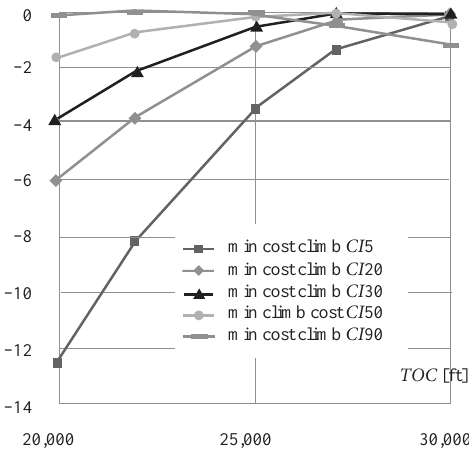
Fig. 13. The change of Δ C D with TOC , for minimum cost climb technique, m c 1 = 51,000 kg